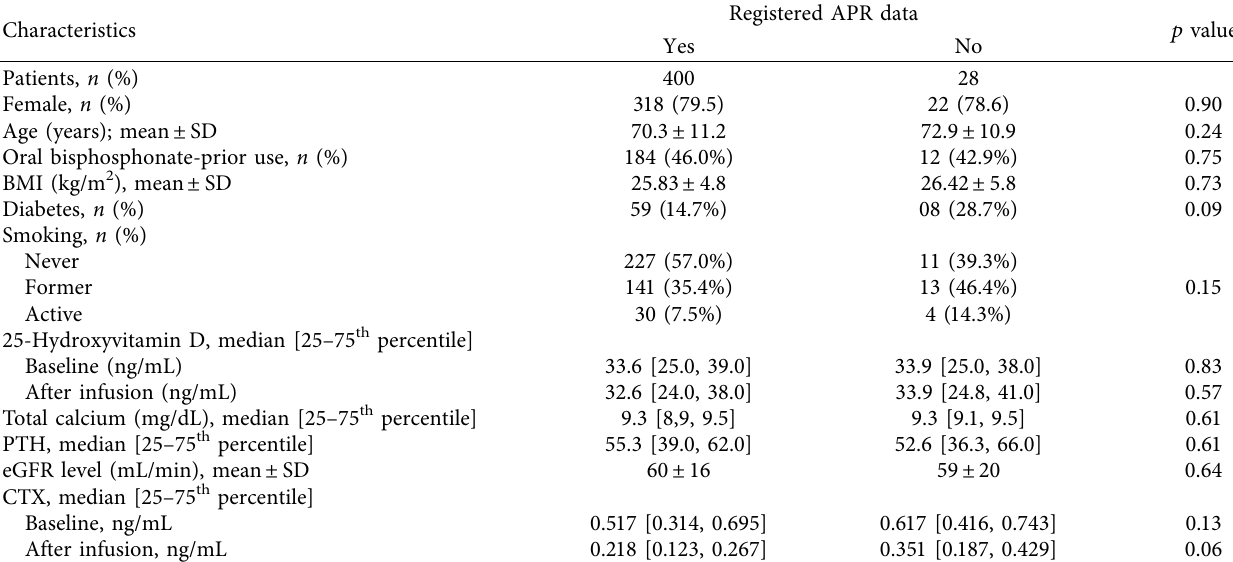
Table 1: Demographic and clinical characteristics of 428 patients with data on CTX according to the presence or absence of registered APR data about zoledronic acid infusion acute-phase response.